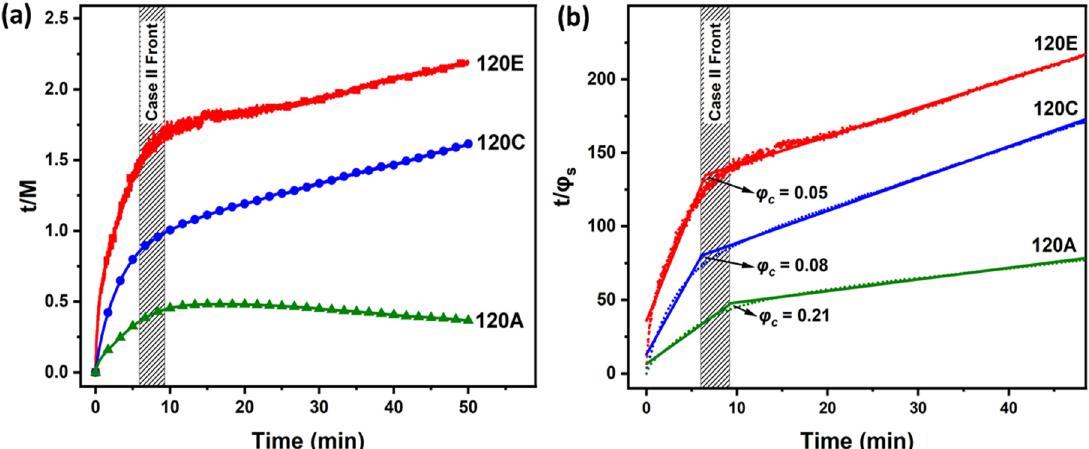
Figure 6. Second order kinetics during swelling. ( a ) Time over mass uptake ( t/M ) and ( b ) time over solvent volume fraction with respect to time. Films were annealed at different heating ramps, 120A ( r T ∼ 4 ◦ C/min), 120C ( r T ∼ 2.94 ◦ C/min ) and 120E ( r T ∼ 0.46 ◦ C/min ). t / M is directly proportional to time, which is characteristic of second order kinetics. t / ϕ s vs. time showing two distinct stages in swelling order kinetics. Solid lines represent linear fits for the relevant